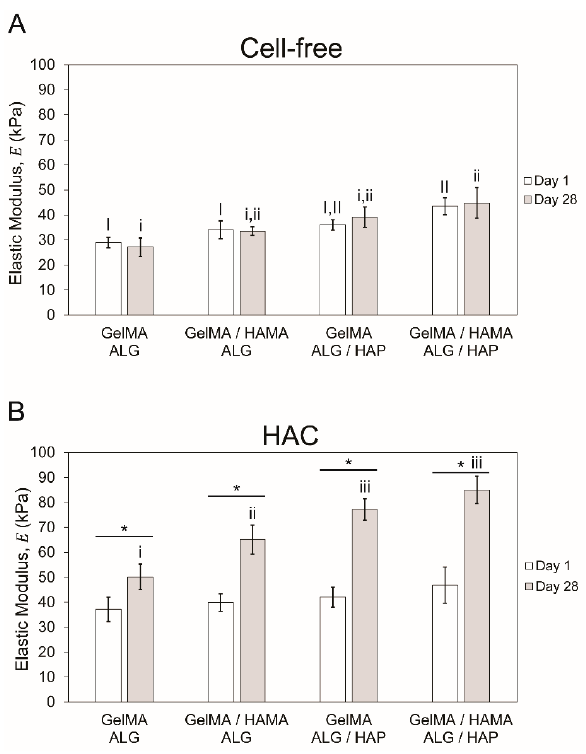
Figure 5. Mechanical testing results showing compressive elastic modulus. Elastic modulus of samples on days 1 and 28 of culture ( n = 3 per group) with ( A ): cell-free and ( B ): cell-containing gels shown separately. The four groups in each time point were compared separately to the second time point, with upper case Roman numerals used for day 1 and lower case for day 28. When groups share Roman numerals they are statistically similar. Bars with stars indicate t -test comparison results between one group across two time points.